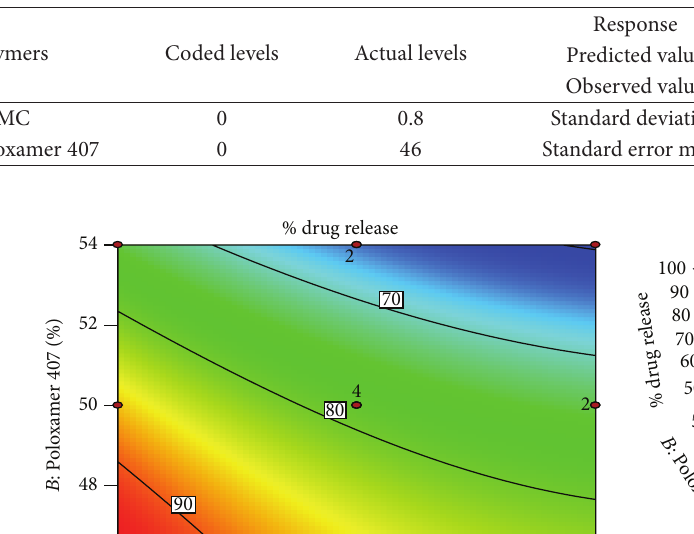
Table 7: Comparison of predicted and actual values of % drug release.